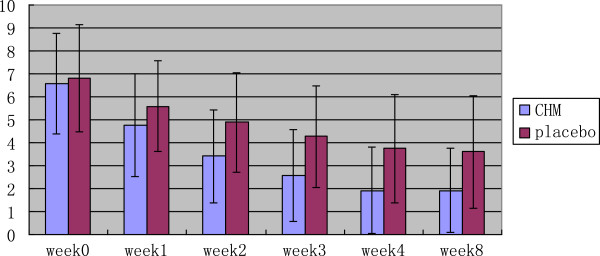
TDS score-change (by patients).